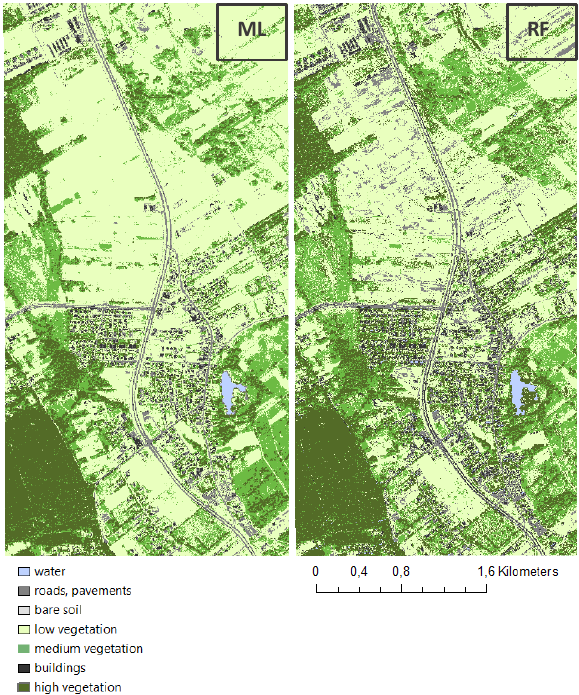
Figure 9. ML (left) and RF - 100 trees (right) results for “W” area. In figure 10 there are visualized buildings classified using ML algorithm (upper image) and using RF algorithm (down image). In ML images buildings appeared more homogenized and smooth while in RF images some parts of the buildings were classified as water (fig. 10-a) what was in fact a shadow (blue colour). On the other hand there are some buildings in ML images not detected at all, while in RF images the same buildings are recognized at least partially (fig. 10-b). The buildings detection is very dependent on spectral properties and similarities to road cover. Yet both classes belong to one group of grey infrastructure.